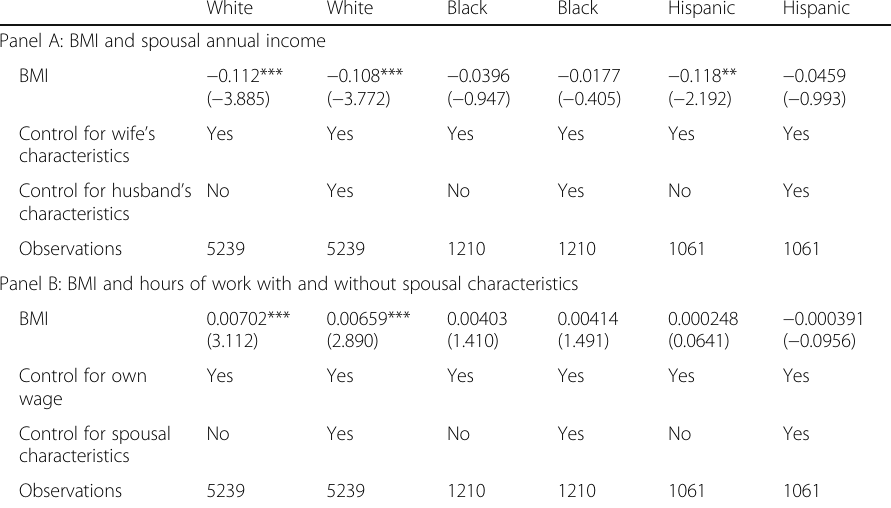
White White Black Black Hispanic Hispanic Panel A: BMI and spousal annual income BMI